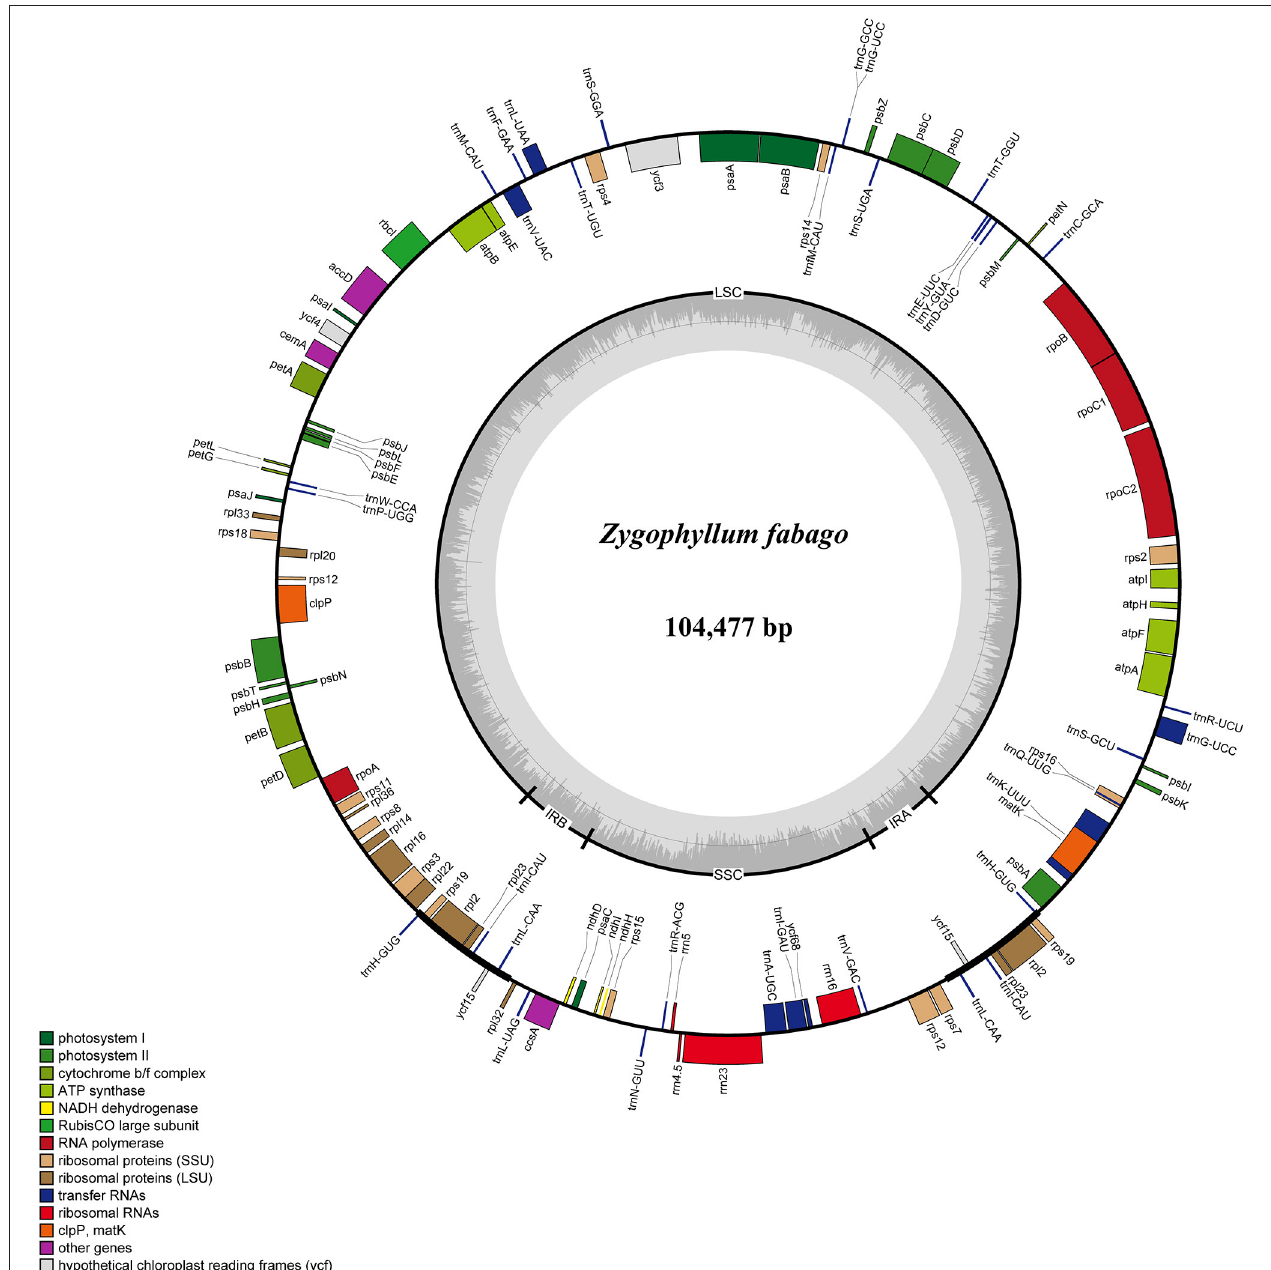
FIGURE 2 | Gene map of the Zygophyllum fabago chloroplast (cp) genome. The genes inside the circle are transcribed clockwise, while those outside the circle are transcribed counterclockwise.